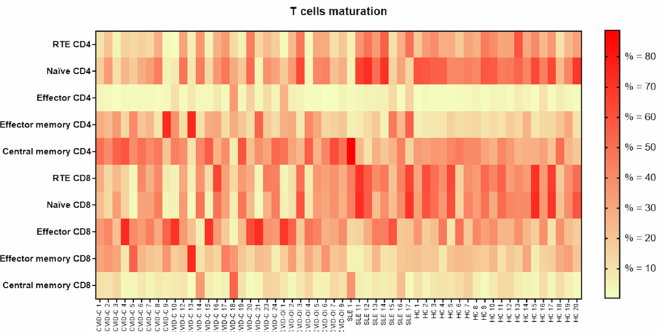
Figure 6. The proportions of T lymphocyte maturation for each patient with CVID with complicated phenotype (CVID-C) group, CVID phenotype limited to only infections (CVID-OI group), patients with systemic lupus erythematosus (SLE), and healthy controls (HCs). Data expressed as a median percentage